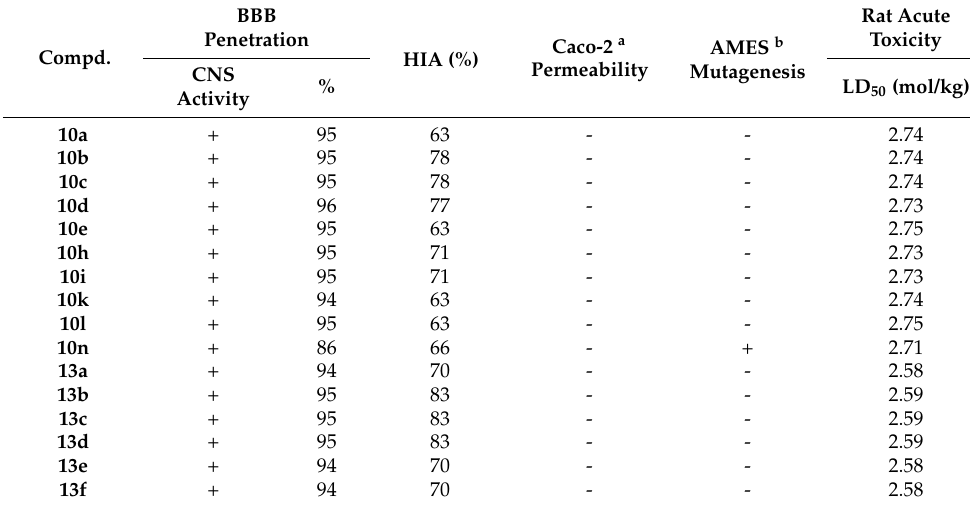
Table 4. ADMET properties and toxicity prediction of selected compounds.